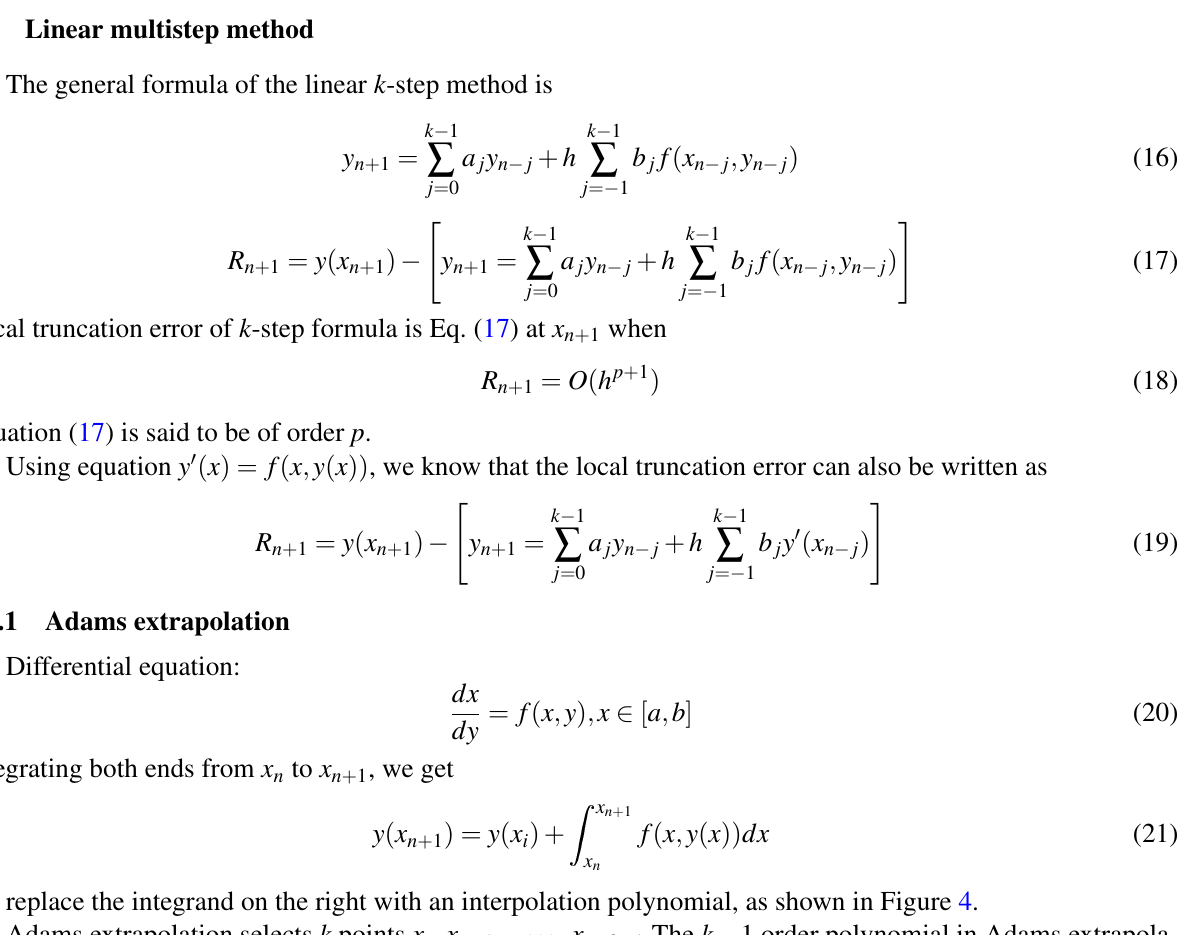
Fig. 3 Runge-Kutta